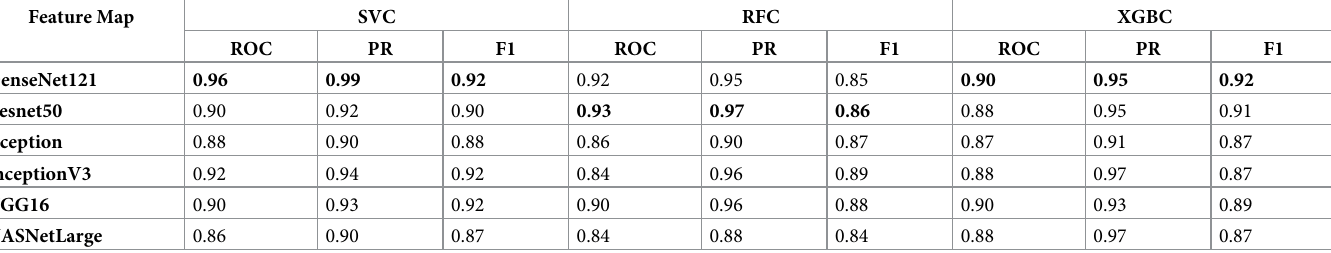
Table 4. Predictive performance for earthworm species prediction across different classification models and deep feature maps on external validation dataset ( E. fetida vs others).